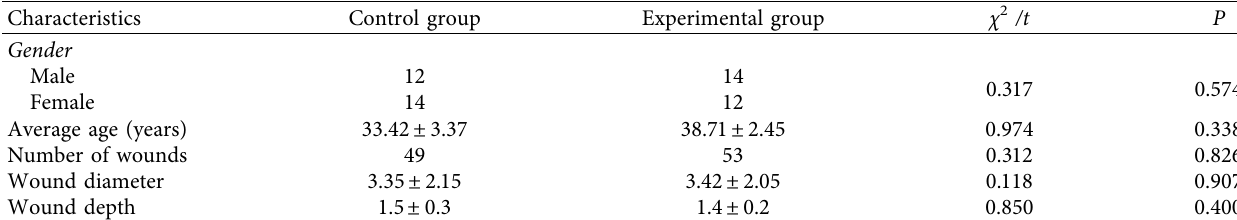
Table 1: Comparison of basic data between the two